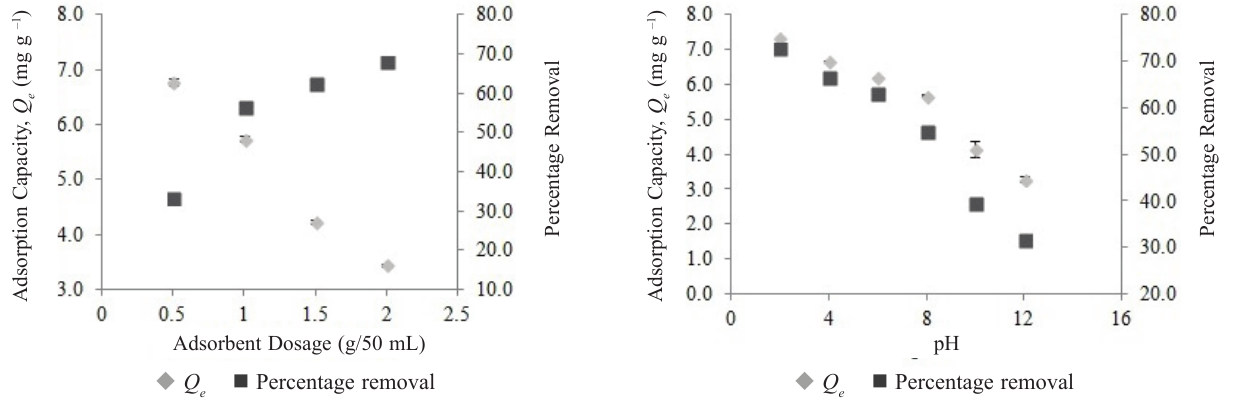
 Percentage removal  Q e Fig. 10 – Effect of pH on percentage removal and adsorp- tion capacity for Reactive Green 19 adsorption (initial dye con- centration = 200 mg L –1 ; adsorbent dosage = 1.0 g/50 mL; contact time = 220 min)